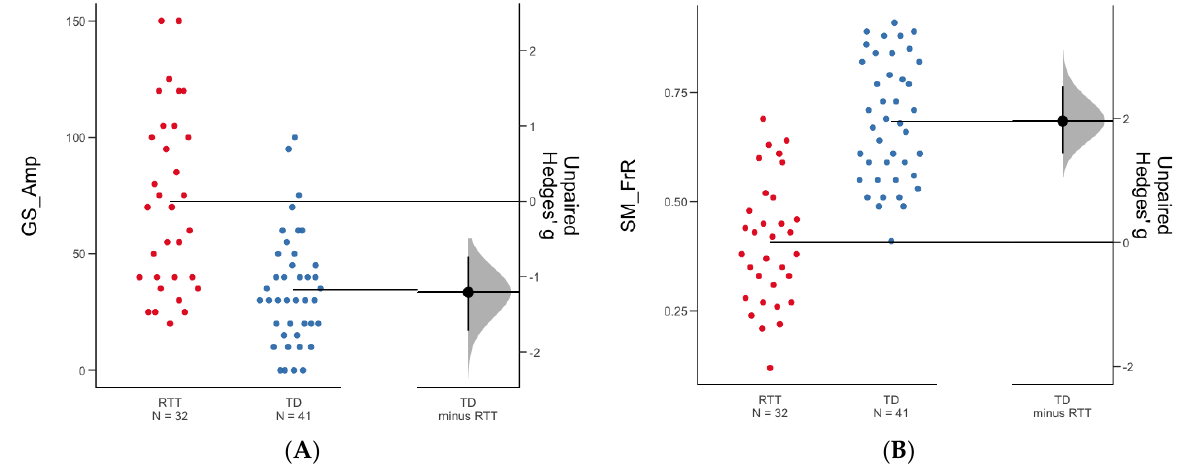
Figure 3. The mean difference between RTT and TD is shown in the above Gardner – Altman estimation plot for two parameters: ( A ) frequency rate of sensorimotor rhythm (SM_FrR); ( B ) amplitude of general slowing (GS_Amp). Both groups (children with Rett syndrome, RTT, and typically developed group, TD) are plotted on the left axes; the Hedges’ g effect size is plotted on floating axes on the right.